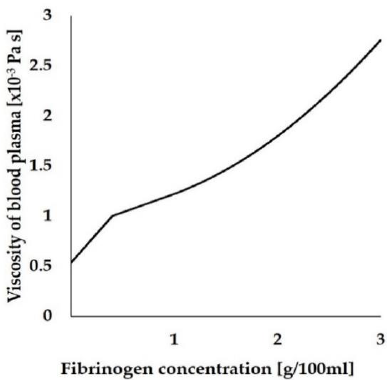
Figure 9. The relationship between viscosity of blood plasma and fibrinogen concentration.